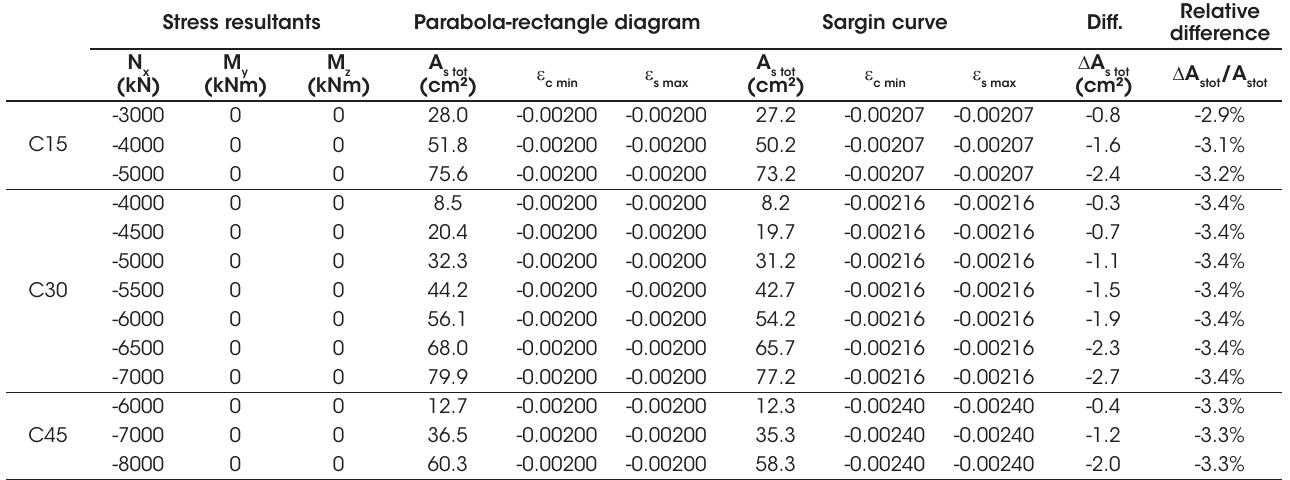
Parabola-rectangle diagram Sargin curve Diff.